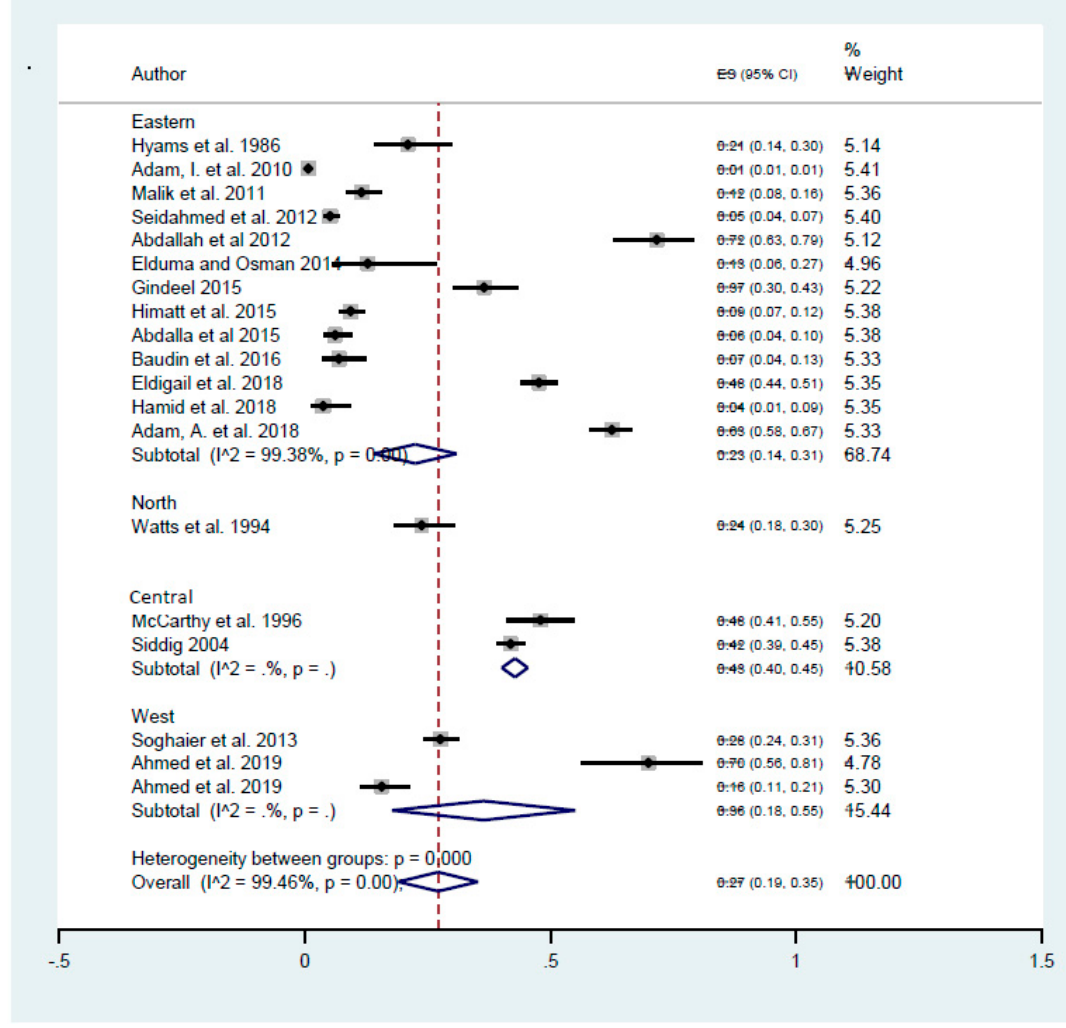
Figure 6. The estimated burden of dengue based on sub-group analysis according to geographical location of the study (regions).